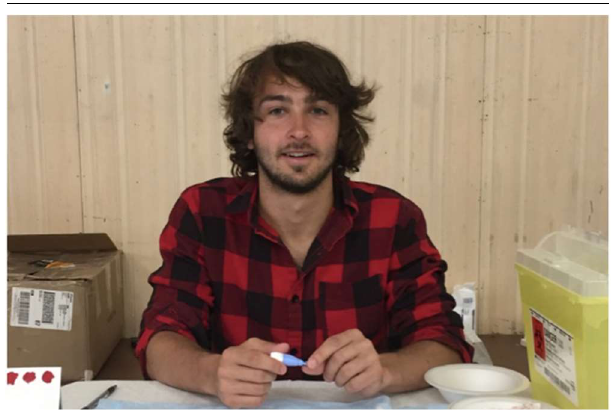
Figure 2. Me Assisting in the Pan-Community Screening Event